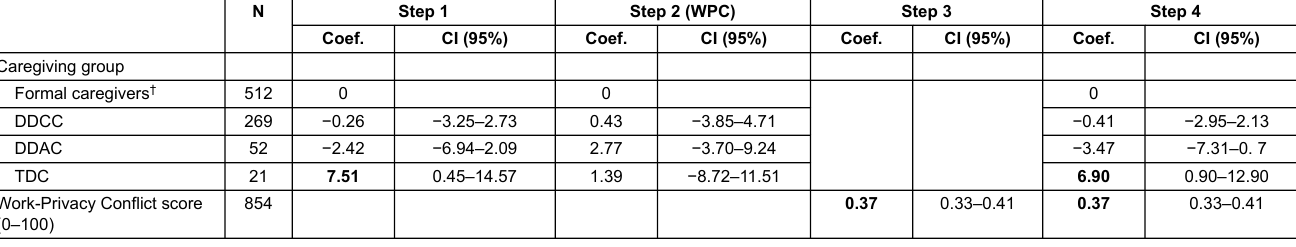
Table 3: Burnout risk for caregiving groups of nursing professionals: four-step mediation analyses*. Step 1 Step 2 (WPC) Step 3 Step 4N Coef. CI (95%) Coef.